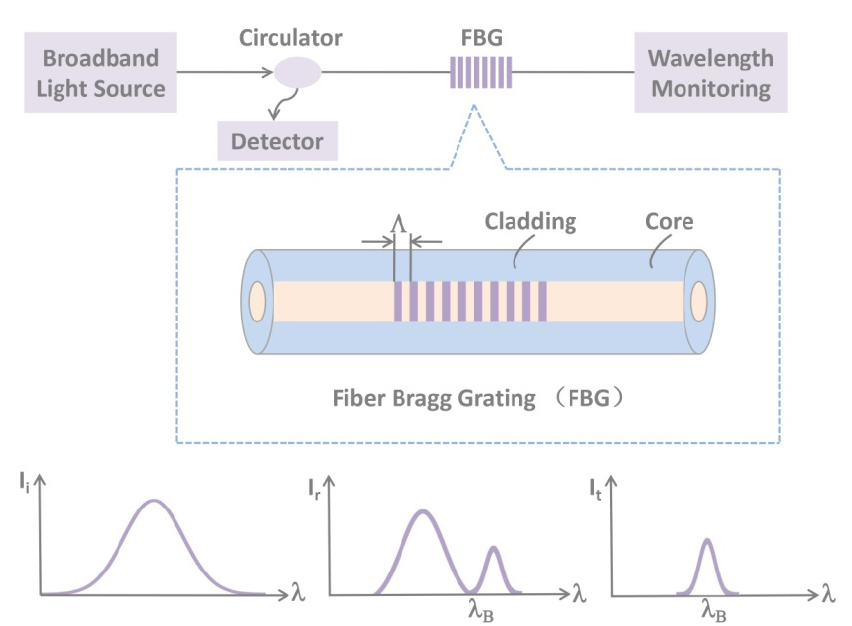
Figure 2. The principles and wavelength shift of fiber Bragg grating (FBG) sensors.